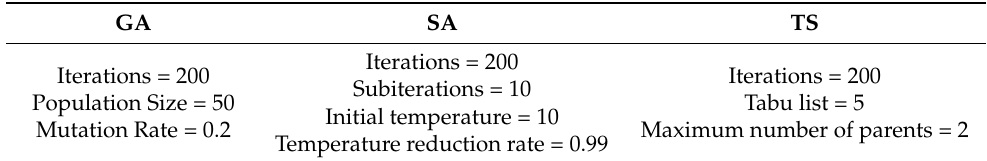
Table 2. Parameters of the metaheuristic algorithms.